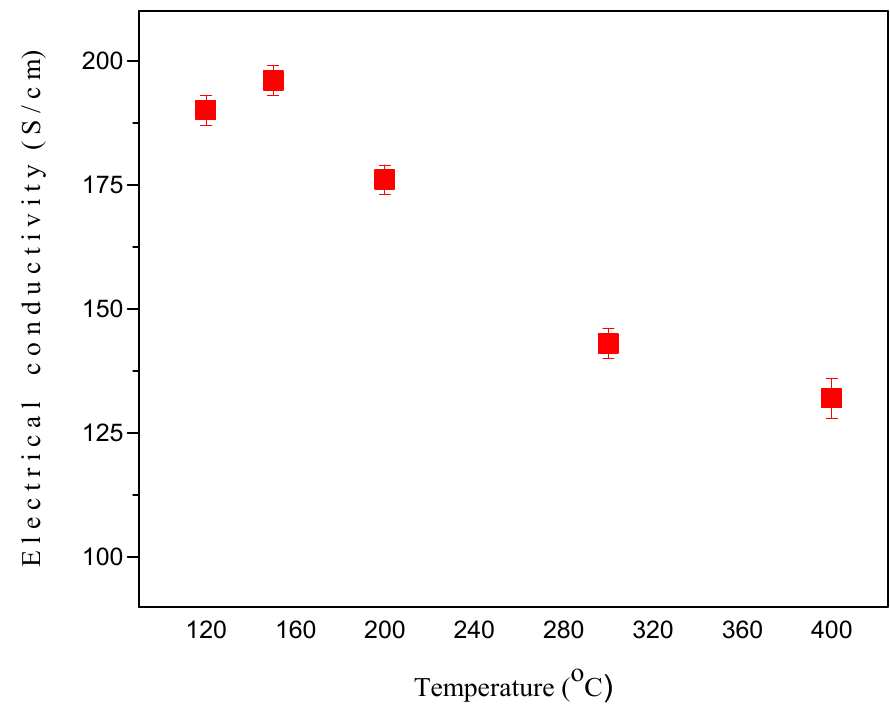
Figure 6. The electrical conductivity of GNPs type 2 plus PEDOT:PSS composite film/CE which was sintered at 120 °C, 150 °C, 200 °C, 300 °C and 400 °C.